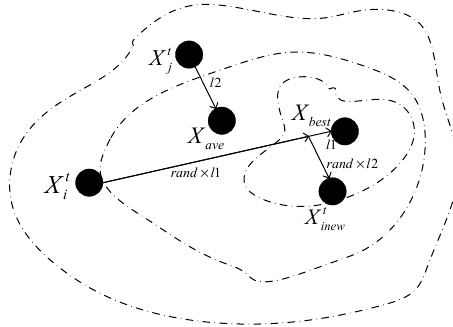
Figure 2. Diagram of the better individual renewal.